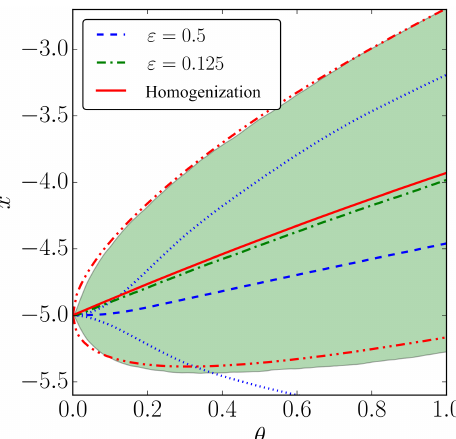
Figure 1. Convergence to the homogenized equations for the ad- ditive triad (Eq. 3) in θ = εt timescale. The red solid and double- dotted dash lines show the analytically calculated mean and 2 σ intervals, respectively, for an ensemble evolving according to the homogenized equation (Eq. 4) from an initial condition x = − 5. The blue dashed and dotted lines show the mean and 2 σ inter- vals for a 10000 member ensemble of the additive triad (Eq. 3) for ε = 0 . 5 from an initial condition (x,y 1 ,y 2 ) = ( − 5 , 0 , 0 ) with √ B ( 0 ) = − 0 . 75, B ( 1 ) = − 0 . 25, B ( 2 ) = 1, γ 1 = 1 /δ , σ 1 = 2 /δ , √ γ 2 = 1 and σ 2 = 2 with δ = 0 . 75. The green dash-dotted line and the green shaded area show the same for ε = 0 .